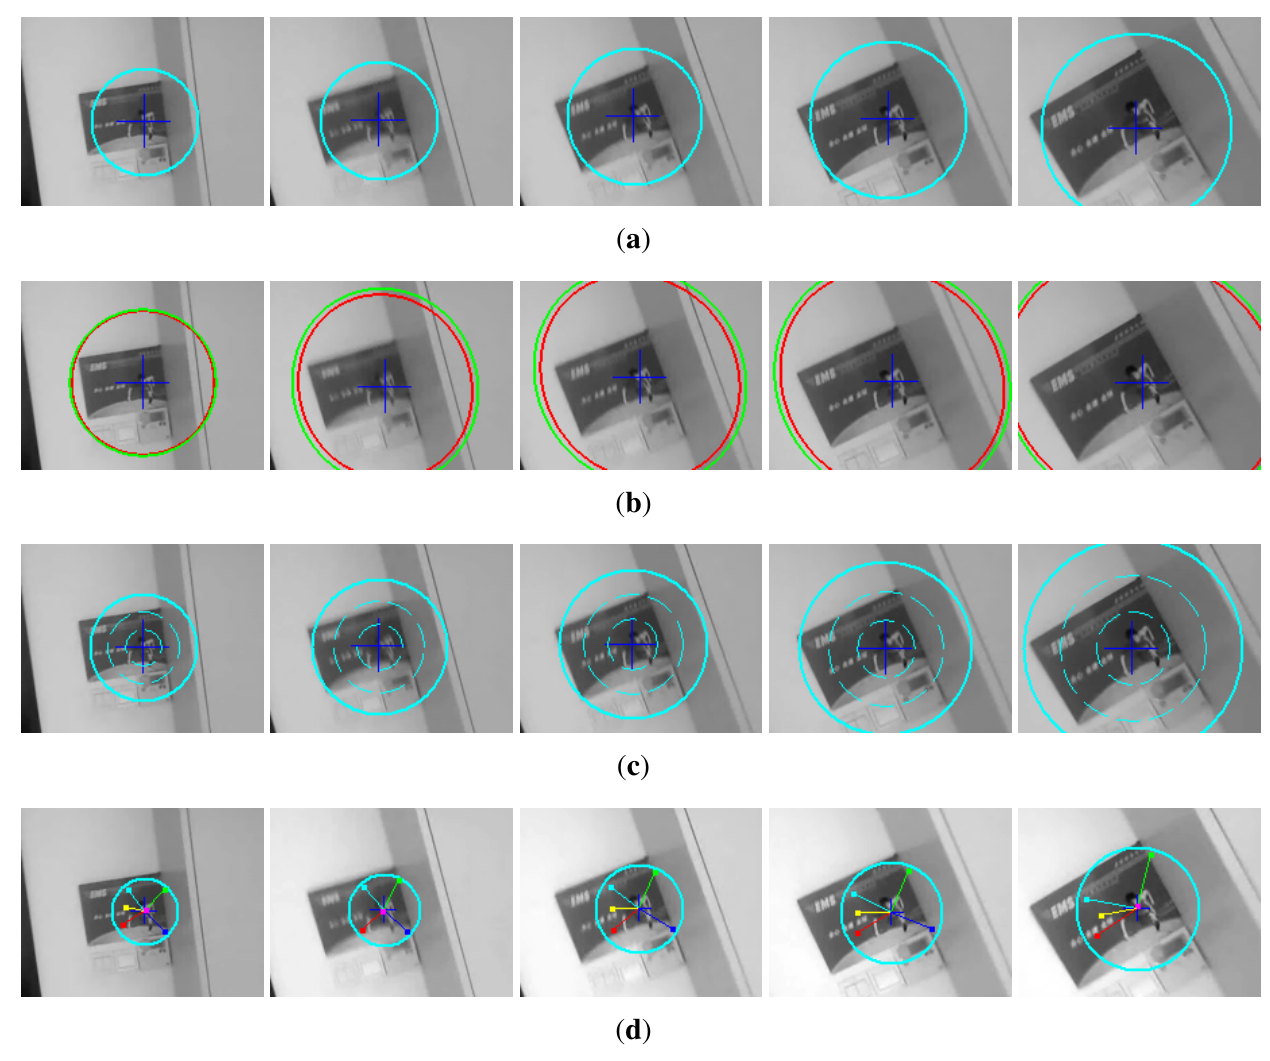
Figure 9. Tracking tests of the 4 methods on the real-life video. ( a ) OMS; ( b ) SOAMST; ( c ) SMS; ( d ) Proposed method.